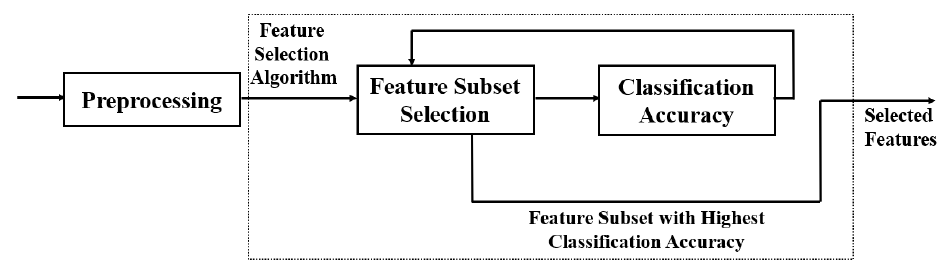
Figure 2. Feature